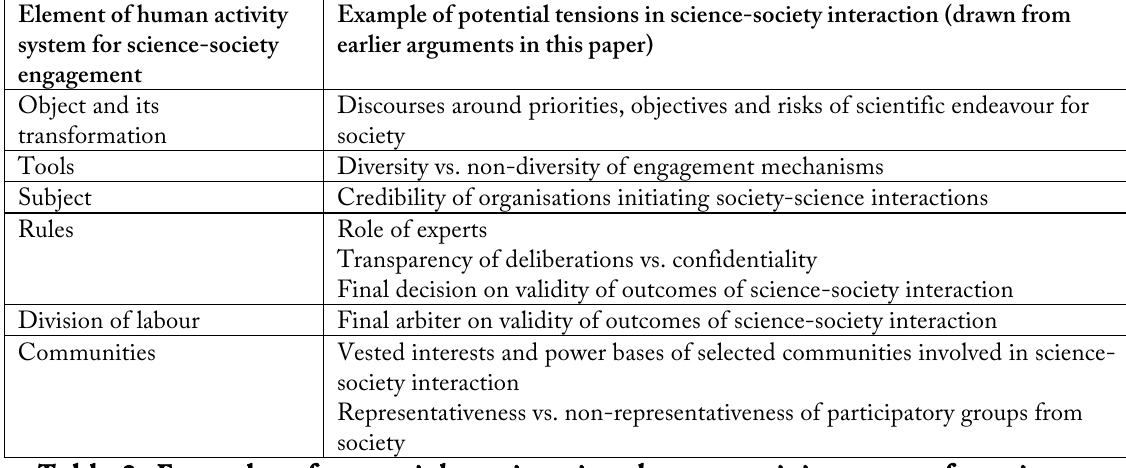
Table 2: Examples of potential tensions in a human activity system for science- society